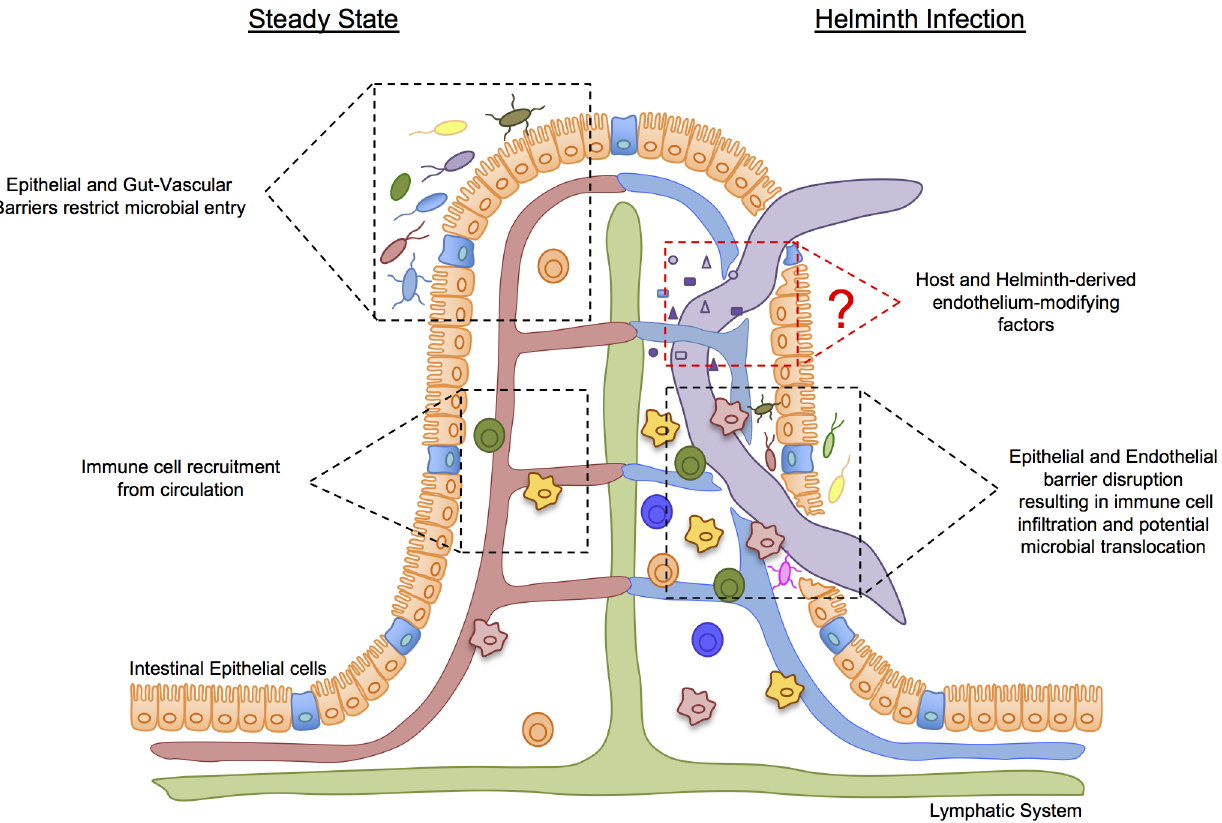
Fig 1. The multi-tasking nature of the intestinal vasculature. At steady state, the intestinal epithelial barrier and the GVB control systemic microbial dissemination and the recruitment of circulatory cells to maintain a tolerogenic environment. During the tissue-invasive stages of diverse parasitic helminth species, a presumed loss of epithelial and endothelial barrier integrity results in a rapid and robust accumulation of inflammatory cells and tissue damage [8]. In this context, both helminth- and host-derived factors contribute to establishing a state of vascular tolerance to limit tissue damage and promote repair. GVB, gut-vascular